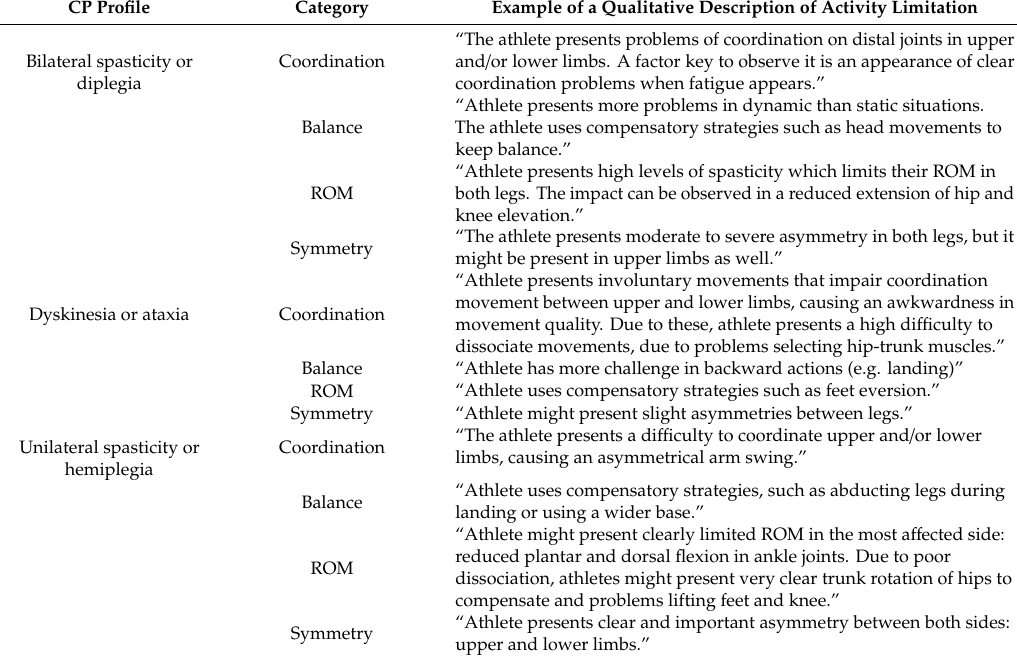
Table 5. Examples of qualitative feedback provided by observers to describe activity